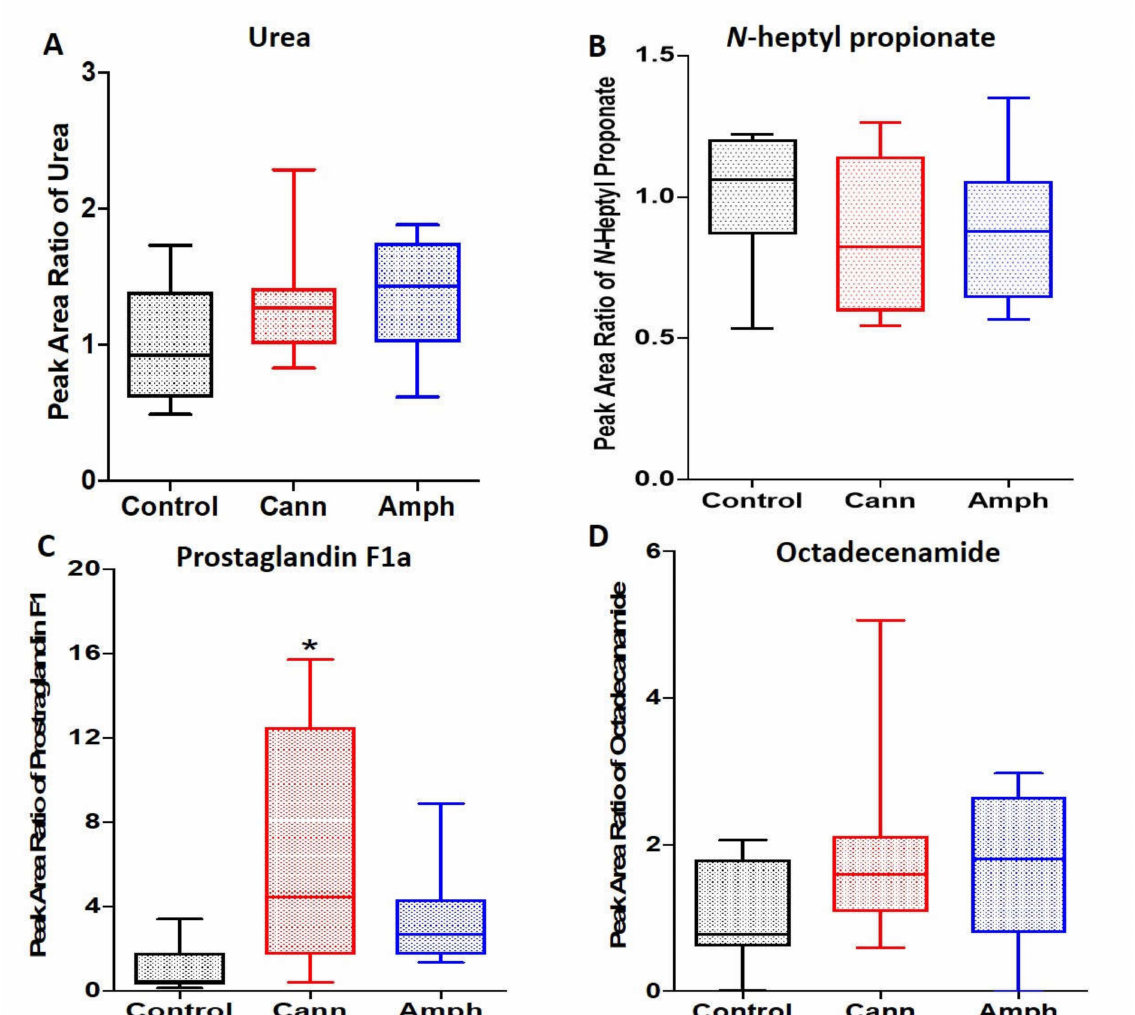
Figure 6. Effects of cannabis or amphetamine on other metabolites in cannabis or